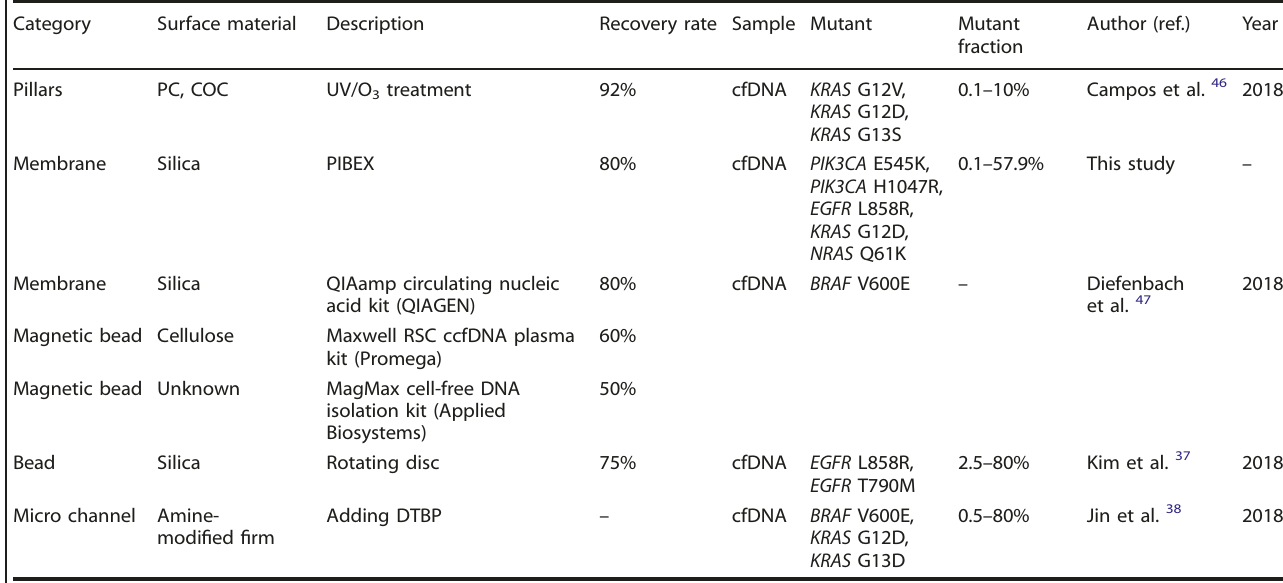
Table 1. Summary of cfDNA